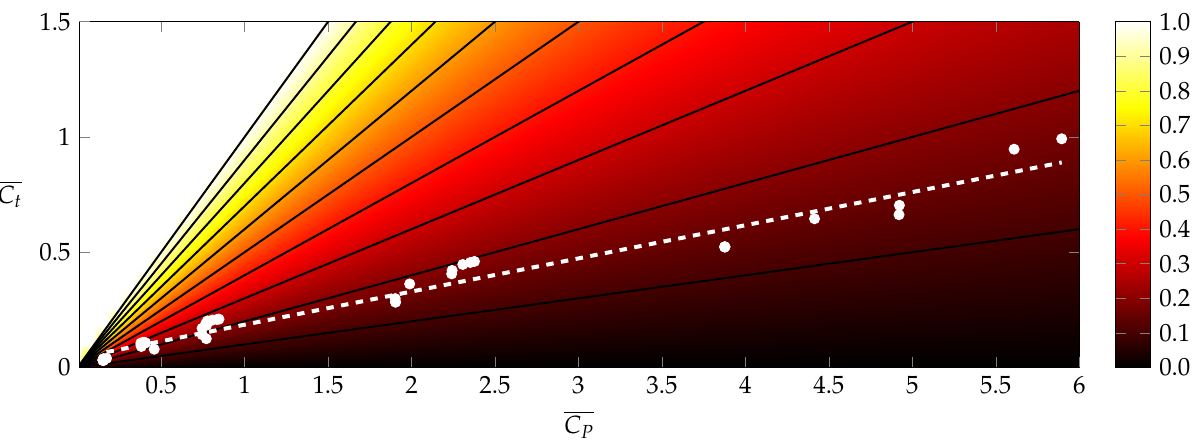
10 4 . Propulsive efficiency is given by the contour ×